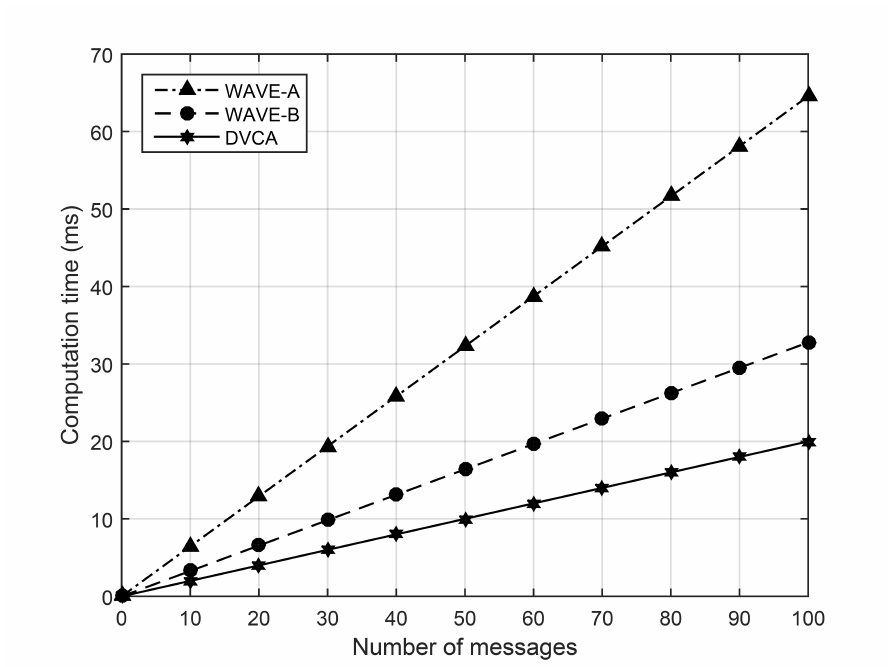
Figure 8. Computational time for encryption and authentication of warning